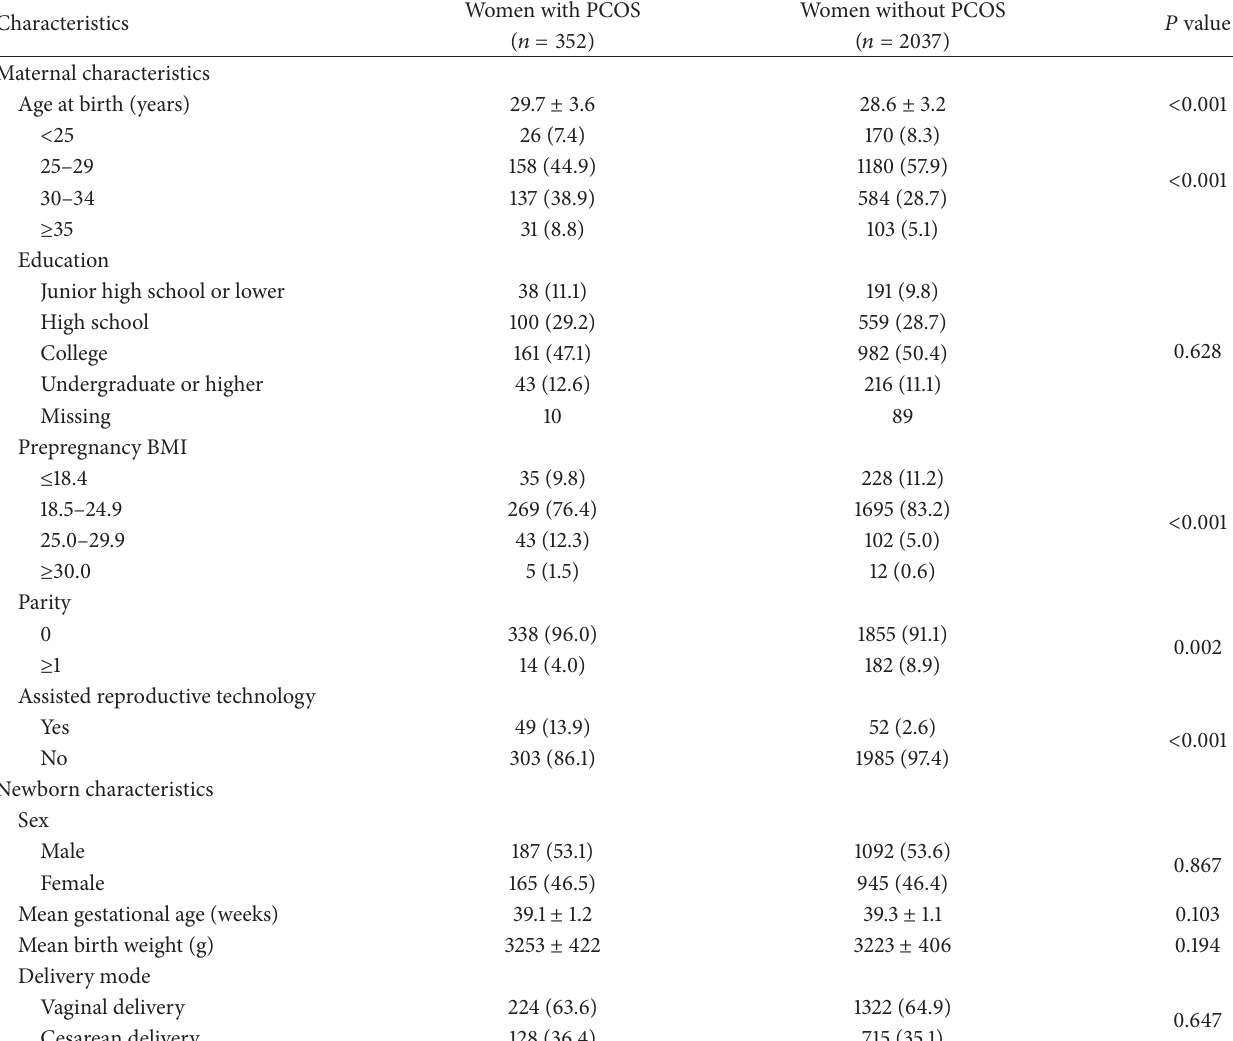
Table 1: Maternal and newborn characteristics according to polycystic ovary syndrome (PCOS)